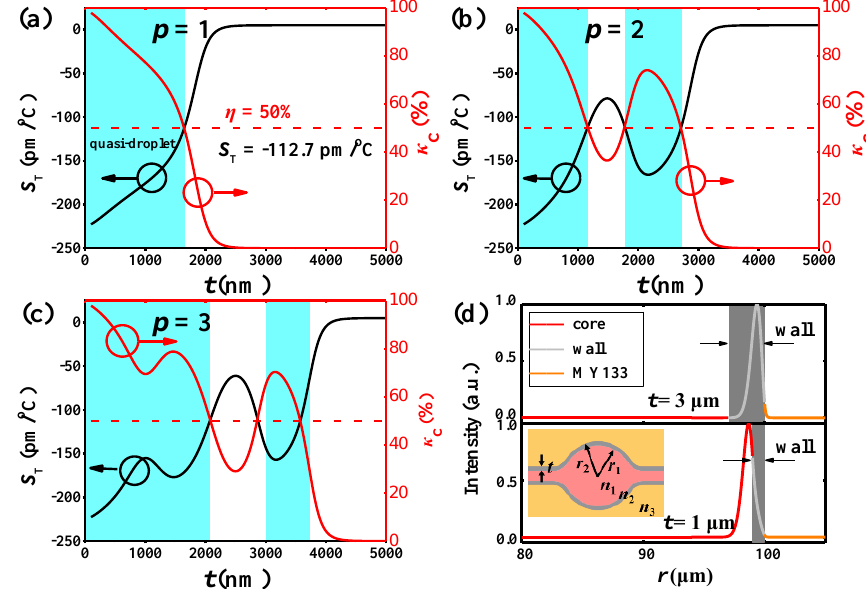
Figure 1. ( a – c ) The calculated sensitivity (left Y axis) and the normalized percentage of electromagnetic energy in the core (right Y axis) for the p = 1–3 modes as a dependence of the thickness of the microbubble wall. The red broken line is a value of 50%. The cyan shadow shows the regime of the quasi-droplet. ( d ) The electromagnetic field distribution of p = 1 mode with wall thicknesses of 1 µ m and 3 µ m (gray shadow), respectively. Inset: the three-layer Mie model. Here: r 2 = 100 µ m, n 1 = 1.479, n 2 = 1.45, n 3 = 1.33.